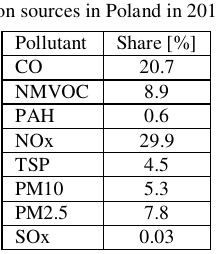
Tab. 2. Share of the annual emission of pollutants from the road transport sector in the total national annual emission of pollutants from all civiliza- tion sources in Poland in 2017